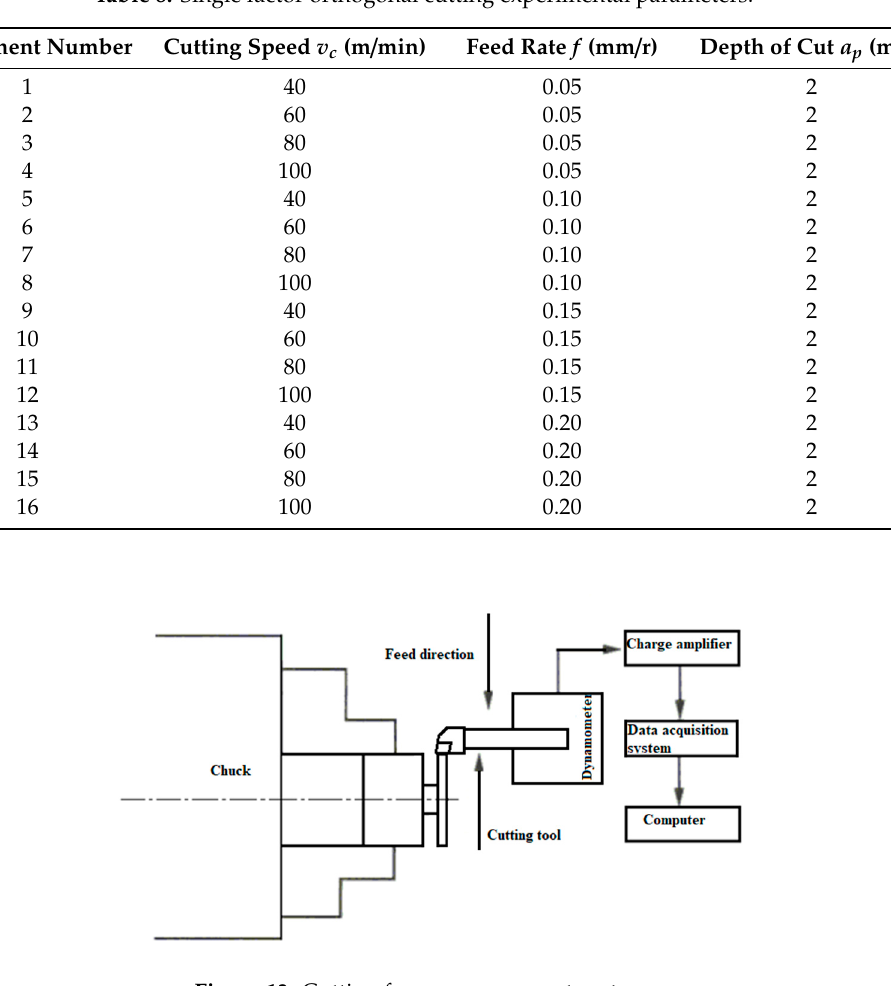
Table 8. Single factor orthogonal cutting experimental parameters.